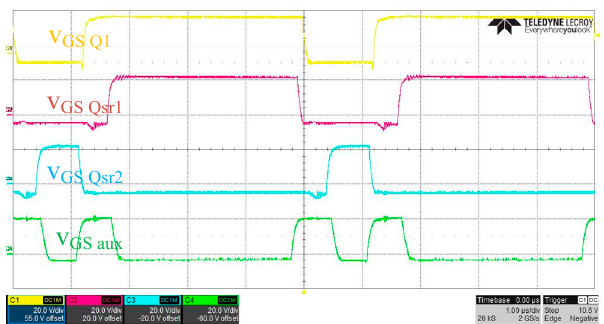
Figure 17. Switch gating signals (scale v GS_Q 1 (Ch1): 20 V/div; v GS_Qsr 1 (Ch2): 20 V/div; v GS_Qsr 2 (Ch3): 20 V/div; v GS_aux (Ch4): 20 V/div; time: 1 µ s/div).